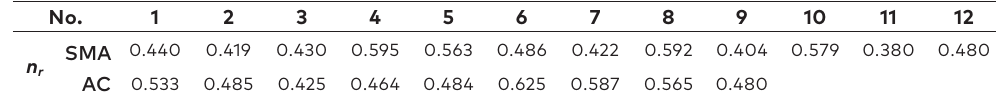
Table 2. The results of calculating the relative number